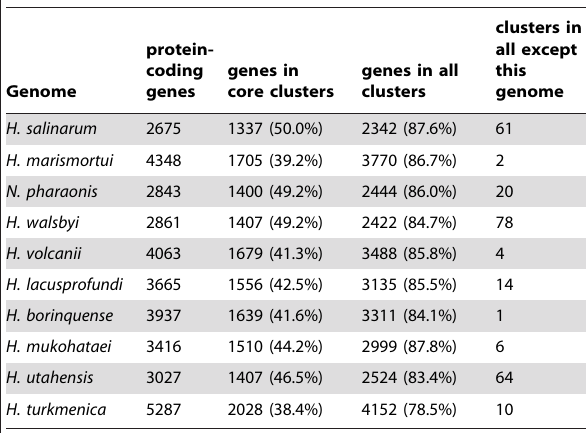
Table 1. Cluster distribution.